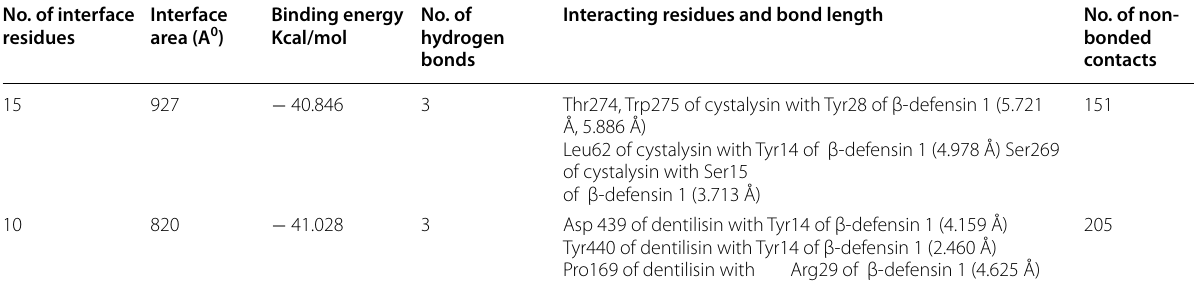
Table 9 Interaction results of β-defensin 1 against cystalysin and dentilisin of T. denticola No. of interface